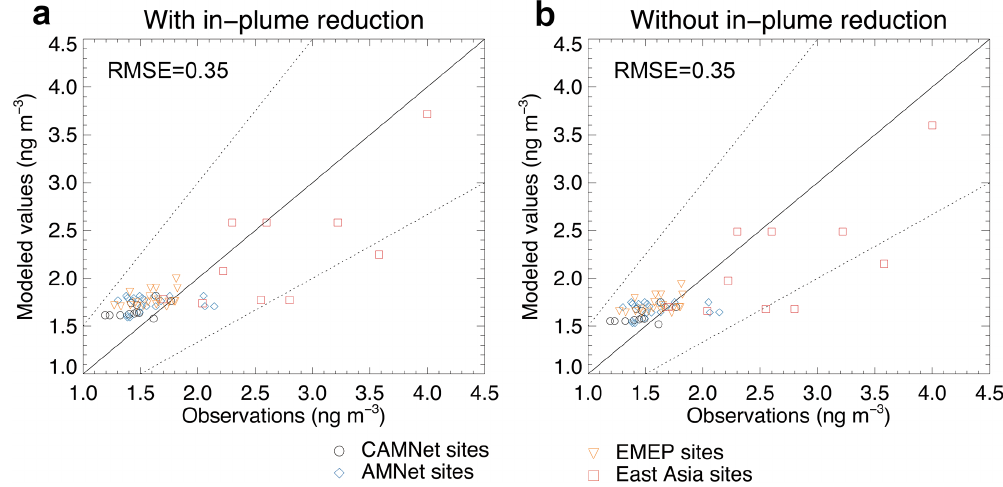
Figure 3. Scatter plot of observed and modeled TGM concentrations under two scenarios: (a) In-plume reduction is used globally; (b) In- plume reduction is not used. The solid line indicates the 1:1 line, while the dashed lines correspond to ± 50%. The RMSE (root-mean-square error) for each scenario is